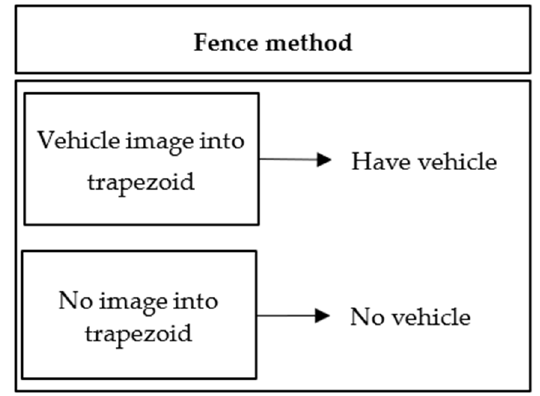
Figure 3. Fence method